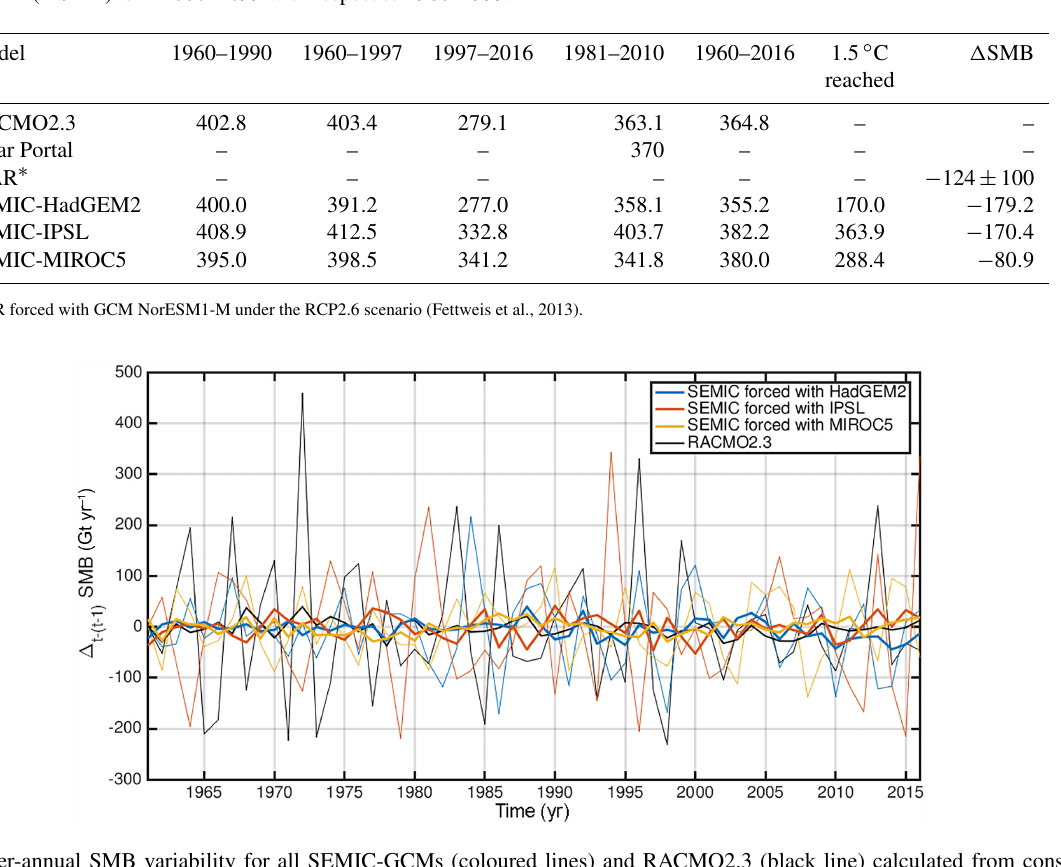
Table 2. Annual mean integrated SMB (Gtyr − 1 ) covering various periods. Time series of SMB clim for the SEMIC-GCMs are calculated by Eq. (4) for the RCP2.6 scenario. The column “1.5 ◦ C reached” shows a 30-year mean at the characteristic time of overshooting 1.5 ◦ C. The anomaly in SMB ( (cid:49) SMB) is in 2080–2099 with respect to 1980–1999.